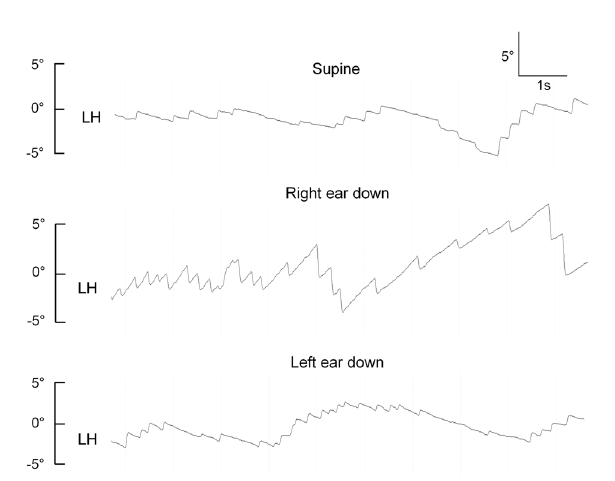
FIGURE2 Apogeotropic positional nystagmus in a patient with an isolated left-sided heminodular infarction (case 1), demonstrating horizontal eye position from the left eye (LH). Upward excursions reflect eye movements toward the right side, downward excursions are consistent with eye movements to the